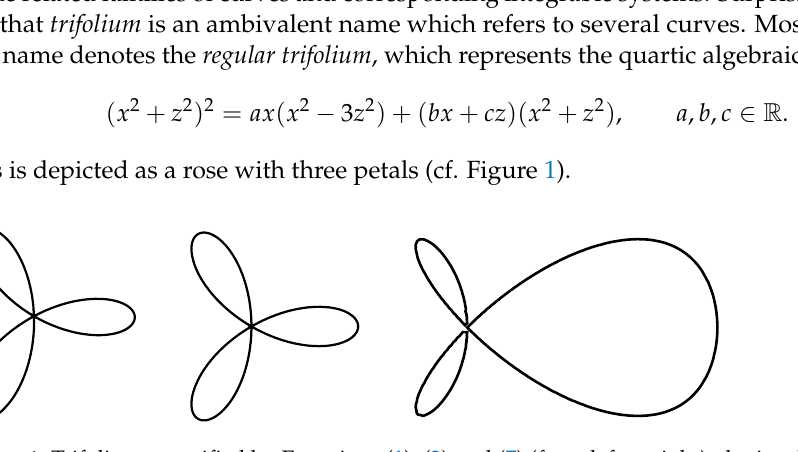
Figure 1. Trifoliums specified by Equations (1), (2) and (7) (from left to right), depicted with parameters a = 5, b = 1/4, and c = 1/2. − −